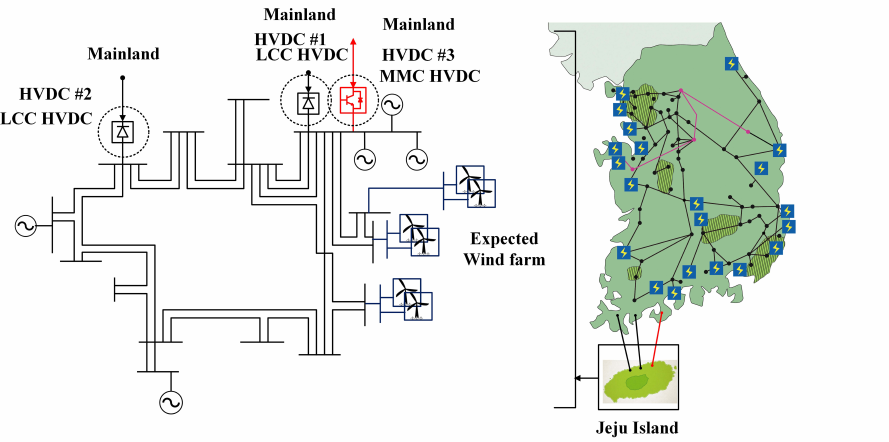
Figure 15. Simple representation of Jeju Island power system for possible MILM scenario in the